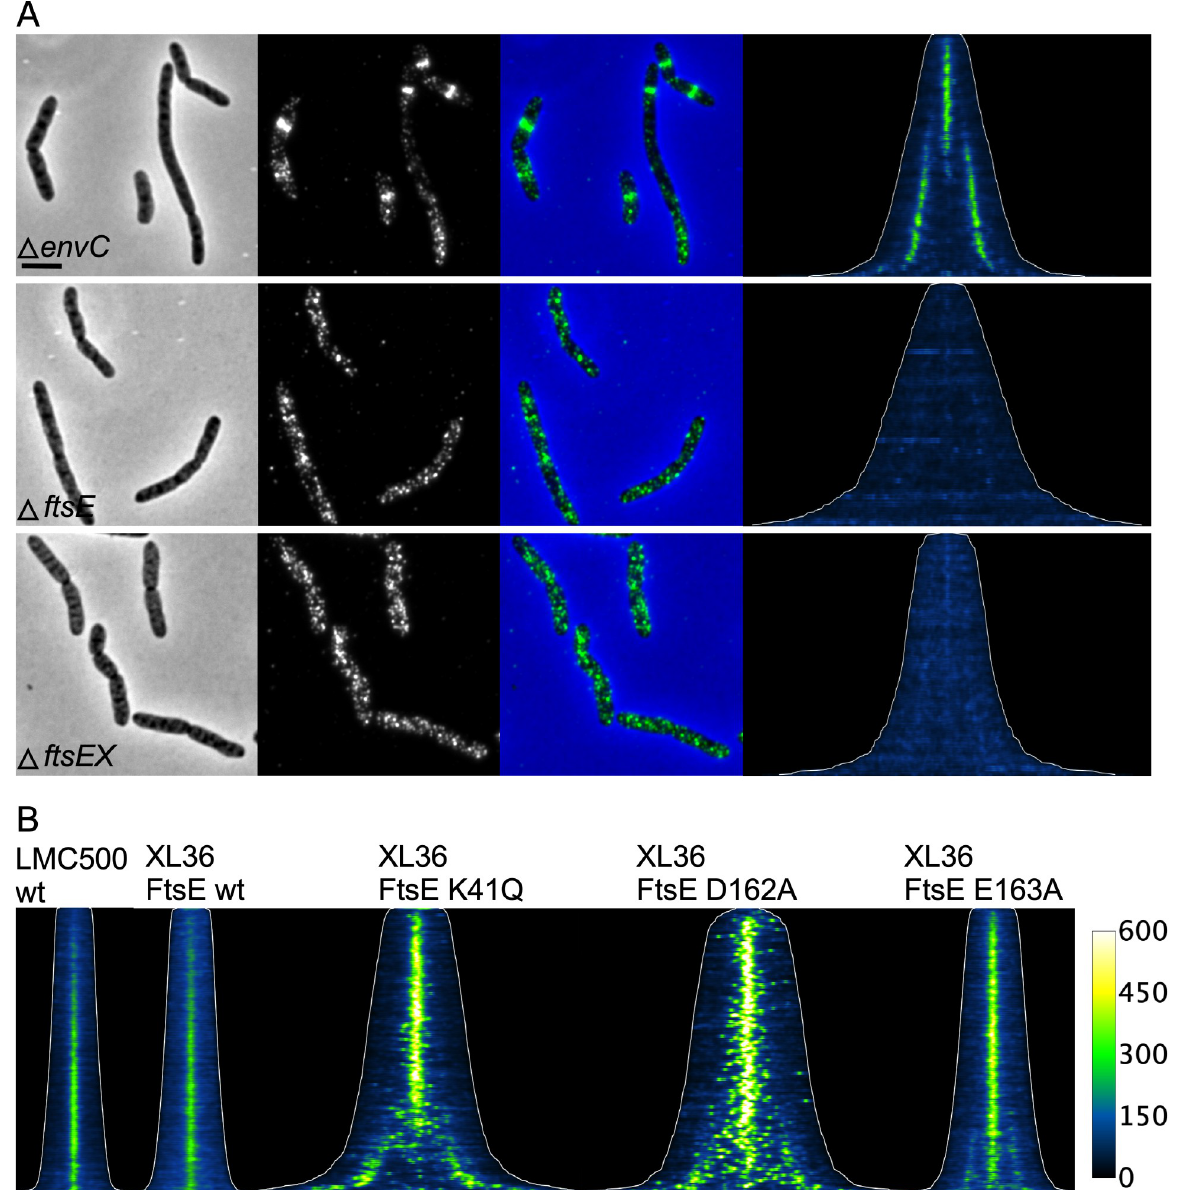
Fig 4. PBP4 is recruited by the septal cleavage complex FtsEX. (A) Cells of BW25113 expressing the proteins indicated were grown in LB at 37˚C to OD 600 = 0.3, fixed and labeled with specific antibodies against PBP4. From left to right, the phase contrast, corresponding fluorescence image of the PBP4 labeling, and the merged former two images, demograph of fluorescence with the cell lengths outlined (with the same contrast and brightness) for all demographs of PBP4 localization where cells are sorted according to their cell length are shown. The number of cells analyzed were 687 for Δ envC , 434 for Δ ftsE , and 346 for Δ ftsEX . The scale bar equals 5 μ m. (B) Cells of LMC500 or XL36 (LMC500 Δ ftsE ::p Trc99A down fts X) expressing wild-type or active site versions of FtsE were immunolabeled with anti-PBP4 antibodies. Cells were grown in TY at 30˚C and FtsE expression from plasmid was induced for 2 mass doubling with 30 μ M IPTG, and cell were fixed and harvested at an OD 600 of 0.3. The demographs of PBP4 fluorescence with the cell lengths outlined is shown for the indicated strains. Number of cells analyzed: LMC500 (2462), wild-type (2588), K41Q (728), D162A (554), and E163E (1052).